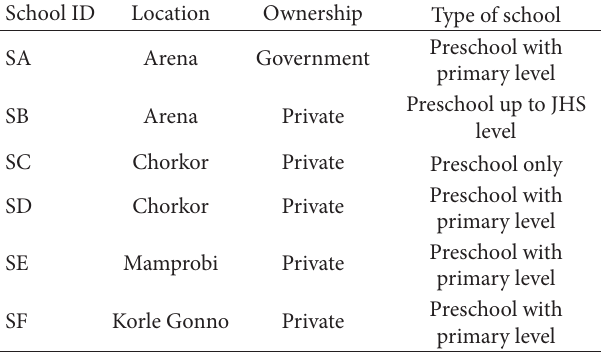
Table 1: Demographic data of schools recruited in the